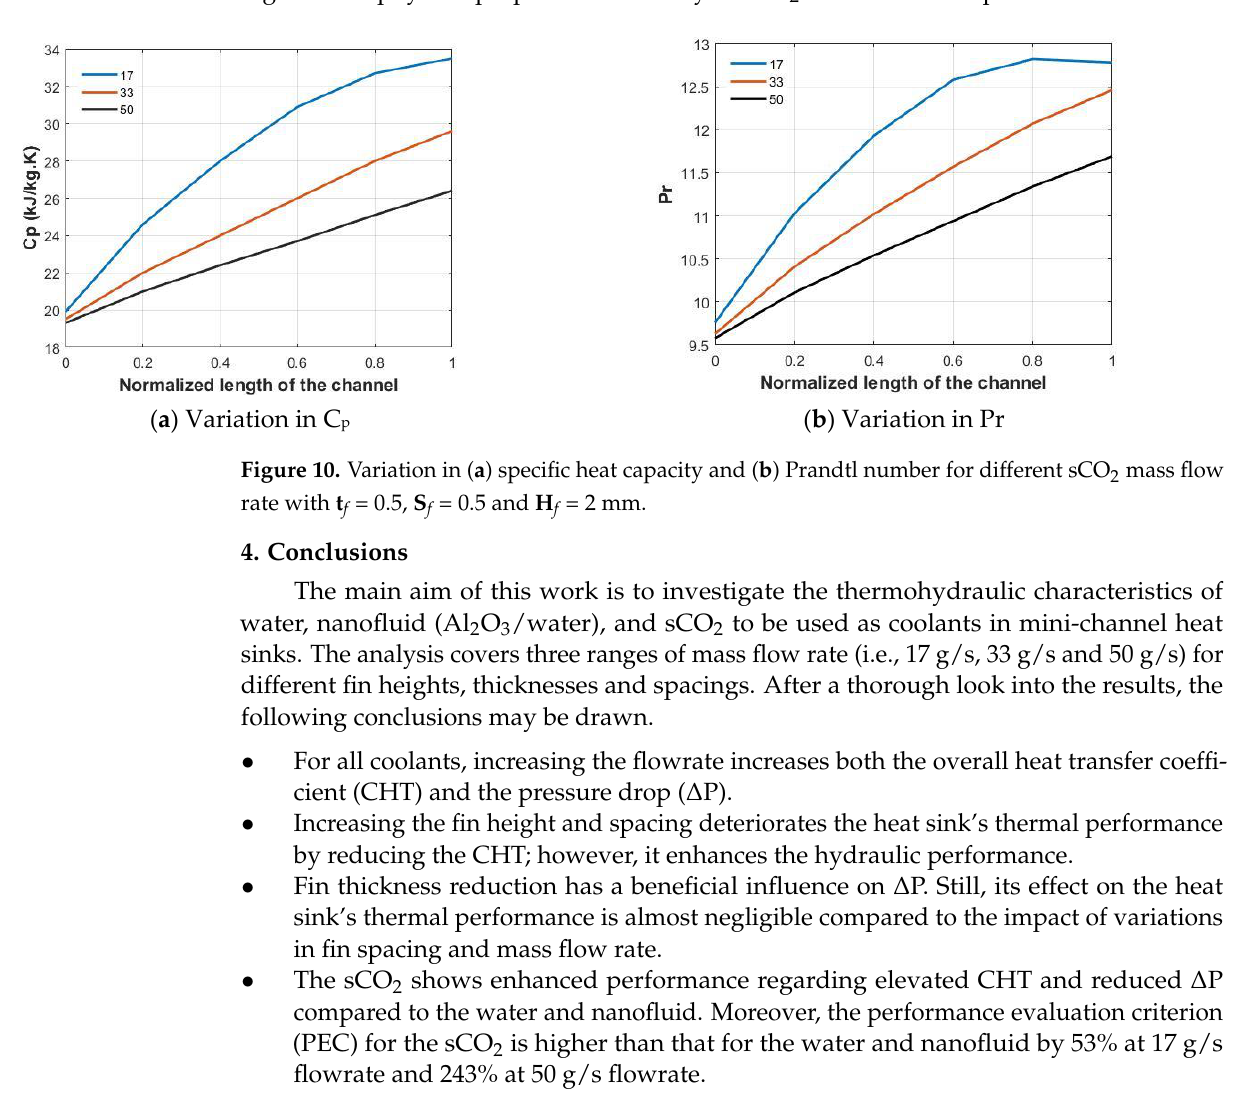
16 of 19 Figure 9. Performance evaluation criteria (PEC) for all coolants corresponding to different flow rates and for H f = 2 mm, t f = 1 mm and S f = 1 mm. In order to have a comprehensive analysis of the thermophysical properties of sCO 2 as a coolant, the specific heat capacity (C p ) and Prandtl number (P r ) are investigated and presented in Figure 10. The analysis is performed for geometry ( t f = 0.5, S f = 0.5 and H f = 2 mm) with variations in the mass flow rate (17 g/s – 50 g/s) to study the impact of ṁ on C p and P r reported in Figure 10. It can be observed from the figure that Pr values increase rapidly along the channel length at lower sCO 2 flow rates until it peaks near the 0.8 of the